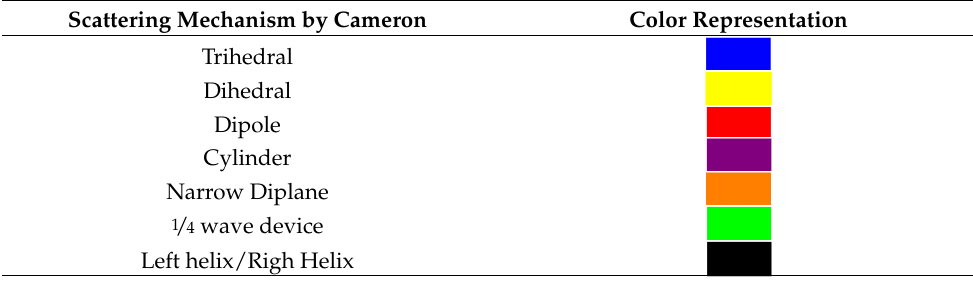
Table 2. Color correspondence with elementary scattering mechanism.